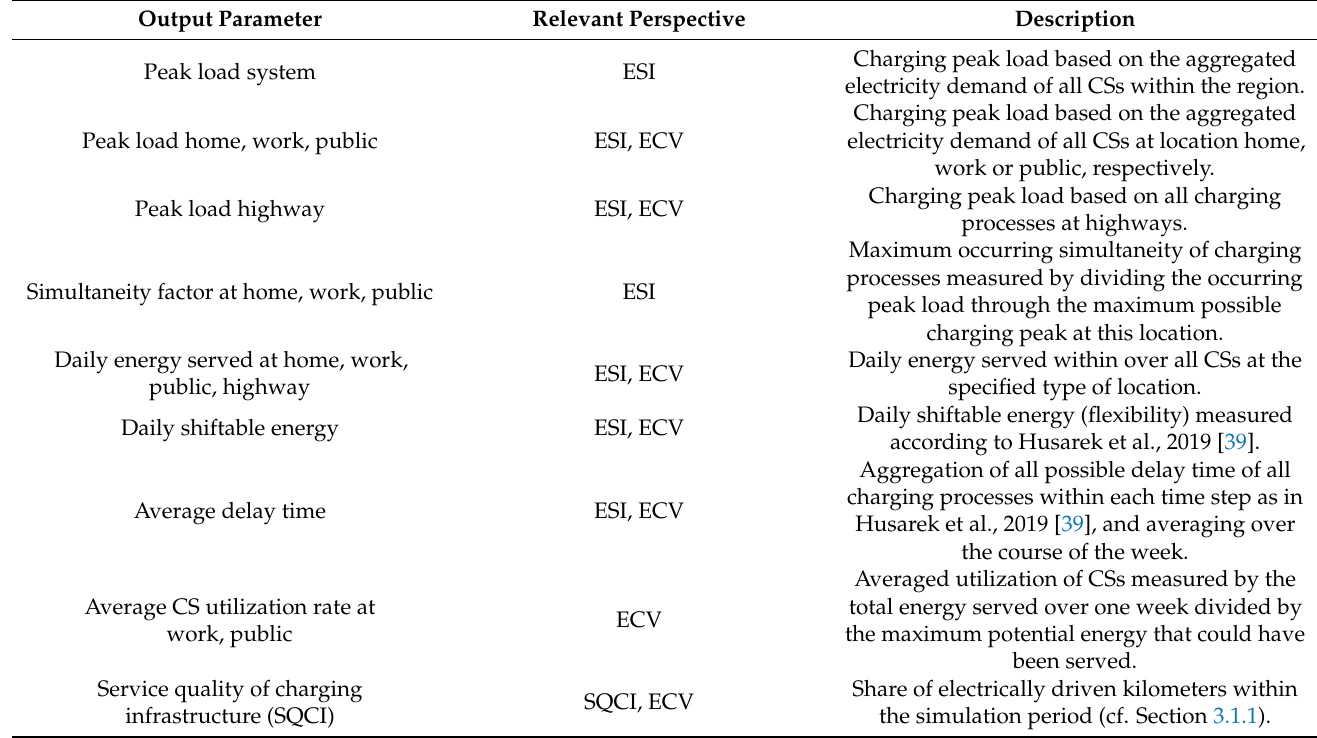
Table 4. Key measures to assess the impact of e-Mobility. ESI—Energy System Integration, ECV—Economic Viability of CS, SQCI—Service Quality of deployed Charging